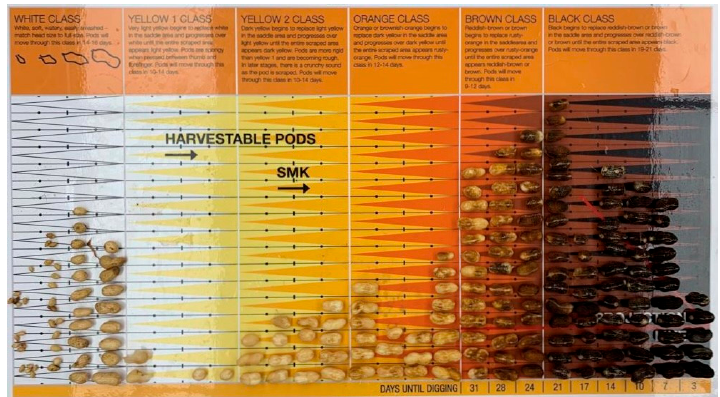
Figure 3. Peanut maturity profile board developed by [10] with pods sorted by color.